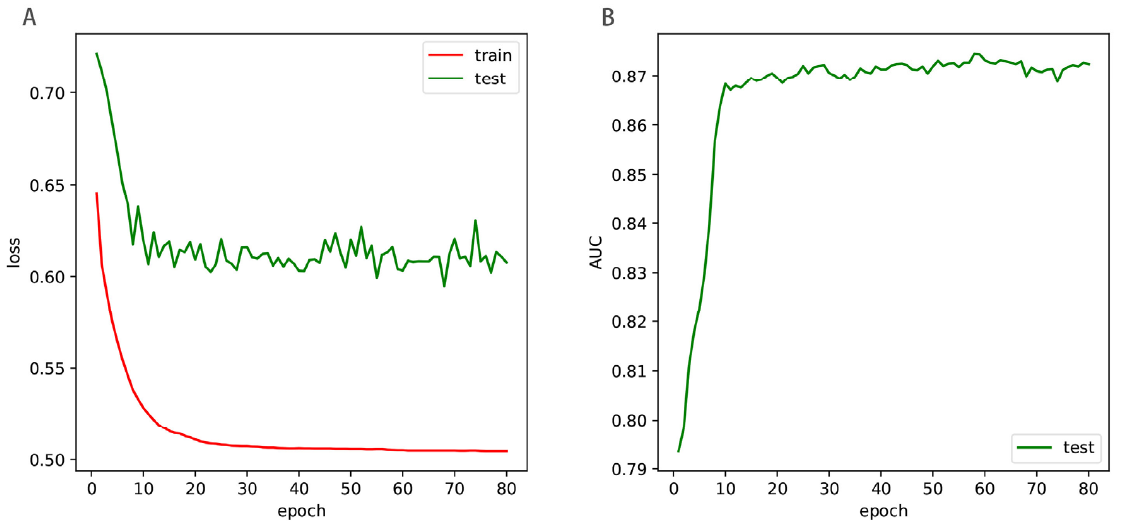
Figure 7. The loss curves ( A ) and the AUC curve of the independent test ( B ). The ‘train’ denoted the training loss in the benchmark dataset, and the ‘test’ denoted the loss in the training set and AUC values of the independent test.